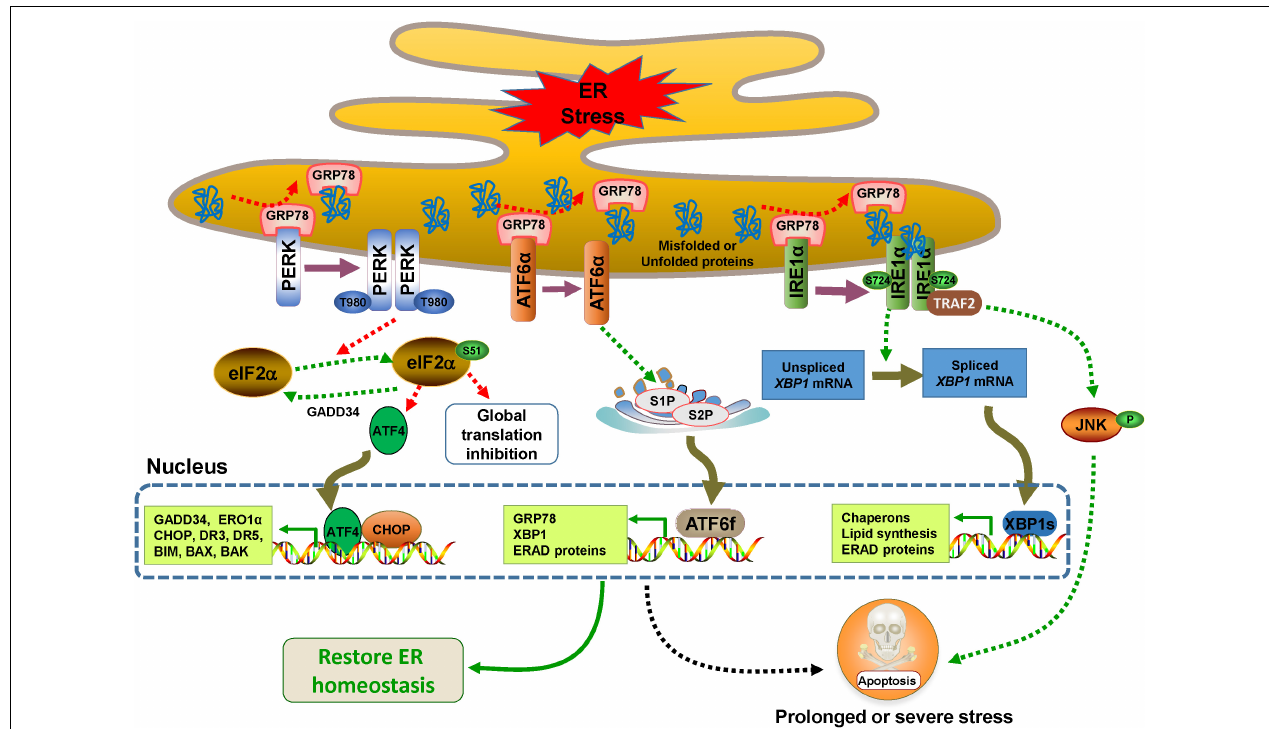
FIGURE 1 | Endoplasmic reticulum (ER) stress and UPR signaling pathways. The UPR is controlled by three major branches, IRE1 α , PERK, and ATF6, which bind to GRP78 in the ER under normal conditions. In response to ER stress, the three sensors are activated by dissociating with GPR78. PERK undergoes dimerization, autophosphorylation, and then decreases protein synthesis by phosphorylating eIF2 α at the Ser51, which selectively results in the translation of transcription factor 4 (ATF4), a factor that activates transcription of its downstream UPR genes such as CCAAT/enhancer binding protein (C/EBP) homologous protein (CHOP) (Harding et al., 2000). CHOP and ATF4 can upregulate the expression of genes involved in the UPR and apoptosis such as BIM, BAX, BAK, death receptor 3 (DR3), DR5, inositol 1,4,5-trisphosphate (IP3) receptor 1 (IP3R1) and ER oxidase 1 α (ERO1 α ) (Iurlaro and Munoz-Pinedo, 2016). When the ER stress is relieved, CHOP and ATF4 induce the expression of growth arrest and DNA damage inducible protein 34 (GADD34), which directly dephosphorylates eIF2 α and restarts global mRNA transcription (Novoa et al., 2001). IRE1 α also undergoes dimerization, and even oligomerization and autophosphorylation, and then, its RNase activity is activated and XBP1 mRNA is cleaved to generate XBP1s. The transcription factor XBP1s is responsible for the expression of a subset of downstream genes involved in ERAD, lipid synthesis, protein folding, translocation, and secretion (Korennykh and Walter, 2012; Hetz and Papa, 2018). Activated IRE1 α also interacts with tumor necrosis factor receptor (TNFR)-associated factor-2 (TRAF2) and promotes a cascade of phosphorylation events that ultimately activates Jun amino-terminal kinase (JNK)-mediated cell death (Urano et al., 2000). The dissociation of GRP78 drives ATF6 to translocate to the Golgi, where it is cleaved by site-1 protease (S1P) and S2P to generate ATF6f, which transcriptionally activates the expression of a variety of genes involved in ERAD and ER chaperones including GRP78 and XBP1 (Haze et al., 1999; Shen et al., 2002; Yamamoto et al., 2007; Hillary and FitzGerald,